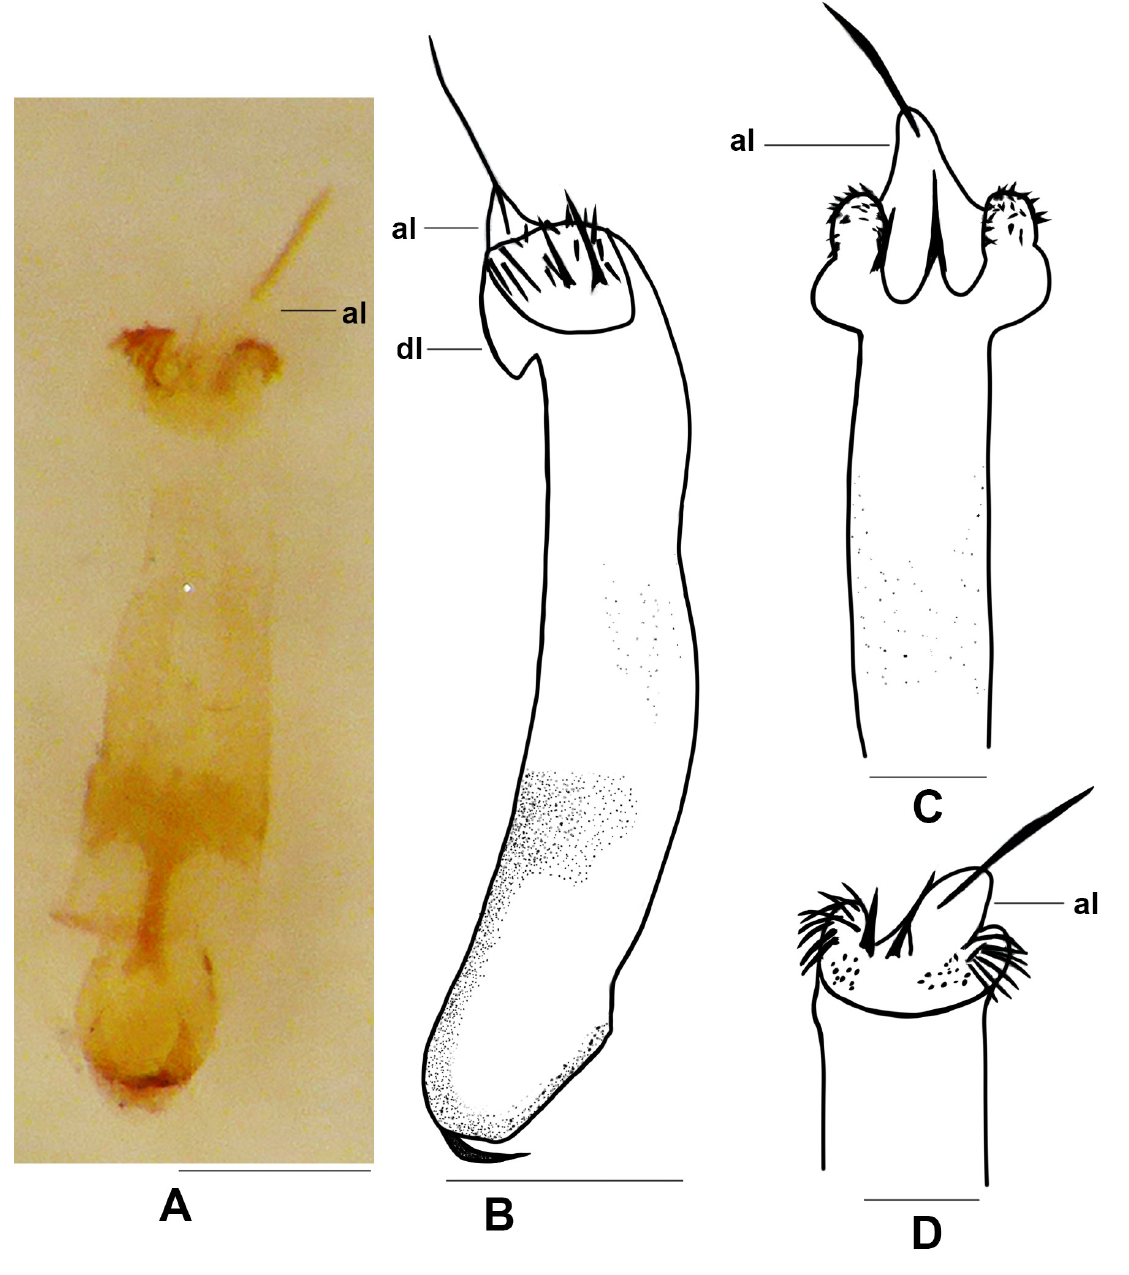
Fig. 7. Chinoperla nigrifrons (Banks, 1939), ♂, holotype (MCZ Type 22693). A . Aedeagus, dorsal view. B . Aedeagus, lateral view. C . Aedeagal sac, ventral view. D . Apex of aedeagal sac, oblique ventral view. Abbreviations: see Material and methods. Scale bars = 0.25